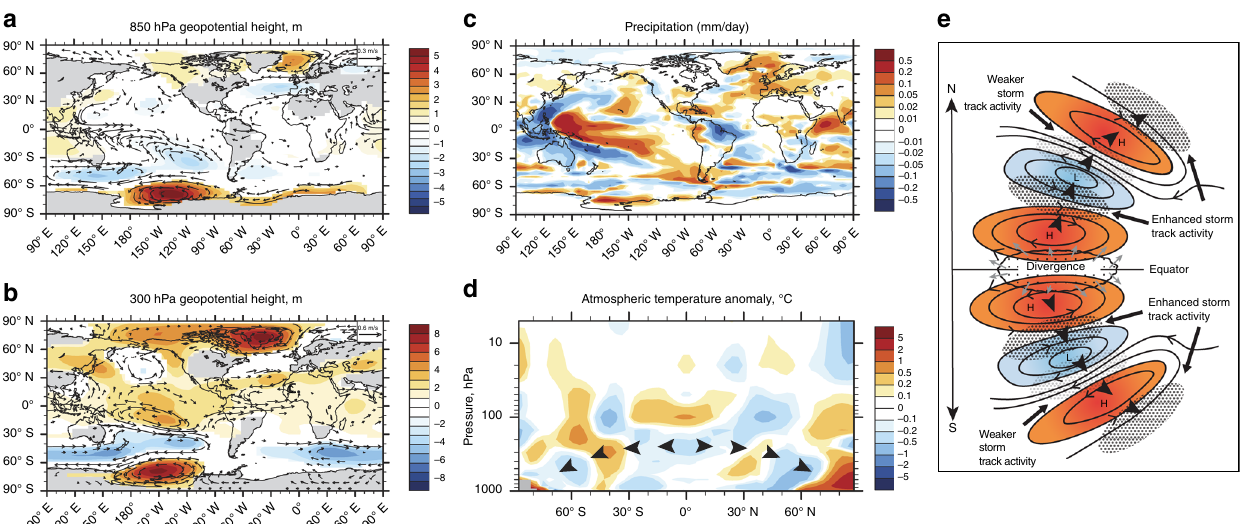
Fig. 4 Modelled global atmospheric propagation of a Southern Ocean freshwater fl ux during the last glacial period. Geopotential height and wind anomalies at 850 hPa a 300 hPa b and global annual rainfall anomalies c . Zonally averaged global temperature anomalies for the atmosphere d re fl ect the characteristic pattern of westerly propagating Rossby waves. a – d produced from CSIRO Mk3L ensemble simulations of a 338-year duration freshwater fl ux of 0.54 Sv into the Weddell and Ross Seas. The schematic in e shows an idealized extratropical Rossby wave train ( solid black arrows ) associated with low ( blue ) and high ( red ) pressure systems generated by anomalous equatorial Paci fi c upper-level divergence 27, 28 . Signi fi cance P <